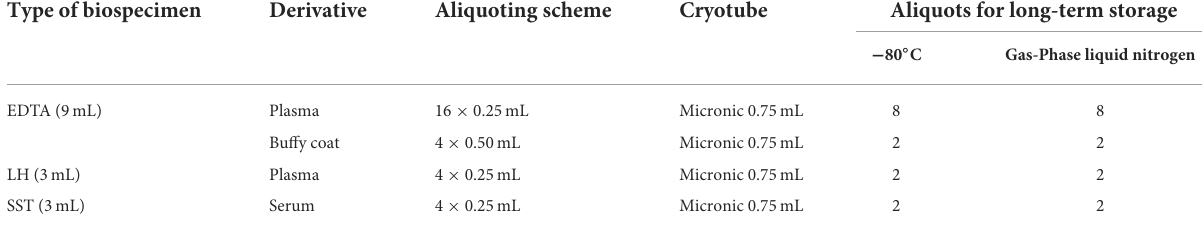
TABLE 2 Aliquoting and storage